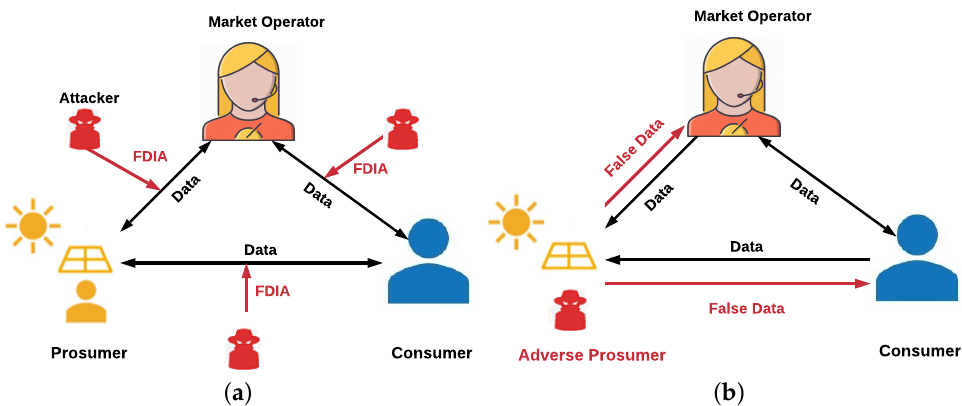
Figure 4. False Data Injection Attacks (FDIAs) through ( a ). Communication channels ( b ). An adverse